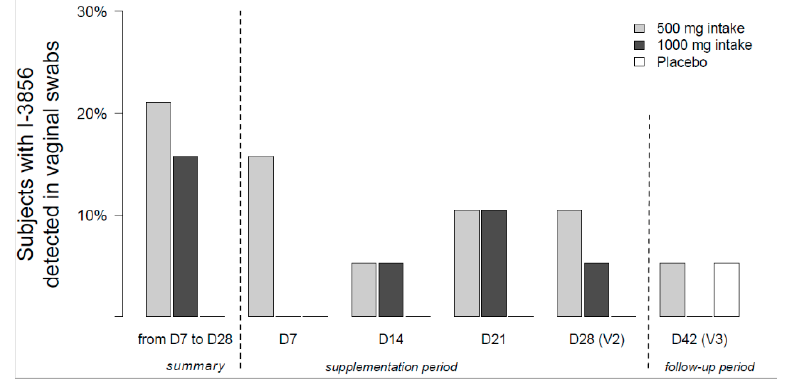
Figure 3. Proportion of women (%) with S. cerevisiae CNCM I-3856 detected in vaginal samples at each study timepoint ( n = 19 for Probiotic 500 mg group, n = 19 for Probiotic 1000 mg group and n = 19 for placebo group).